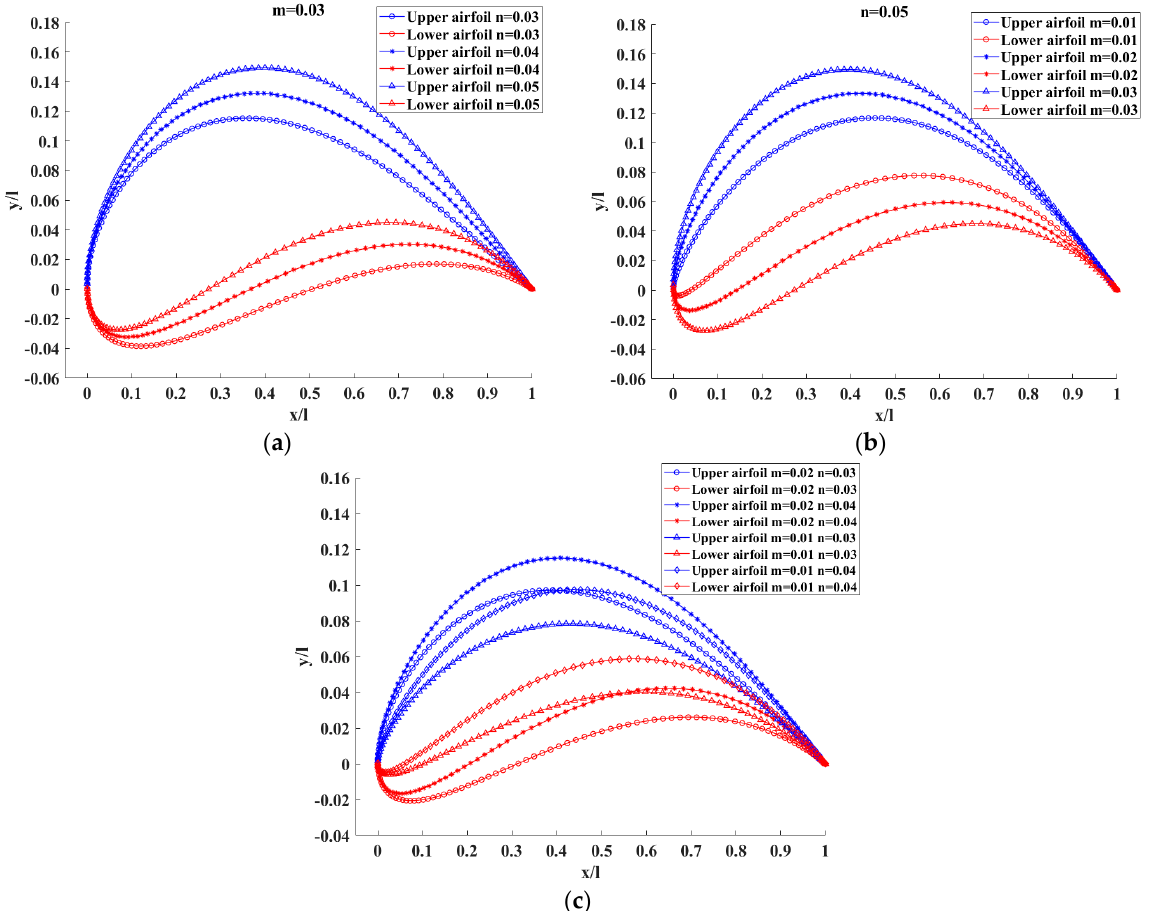
Figure 2. Influence of parameter changes on airfoil shape. ( a ) m = 0.03; ( b ) n = 0.05; ( c ) different values of m and n. However, whatever the parameter values are changed to, the relative thickness posi- tion of the obtained airfoil is at 25% of the chord and the relative camber position is at 50% of the chord. The relative thickness position and relative camber position are unchanged, and the relative thickness value and relative camber value of the airfoil can only be changed at a specific position. 3. Sectional Expression Model of Wind Turbine Airfoil Function As shown in Figure 3, to solve the situation that the relative thickness position and the relative camber position are fixed, the circle in the second quadrant is modified to a rotating elliptical circle. Then, the Joukowski transformation is applied to obtain the airfoil with variable relative camber, relative thickness, relative camber position, and relative thickness position on the plane z .